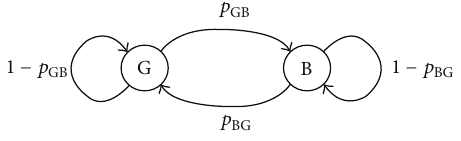
Figure 1: Two-state Markov model for burst